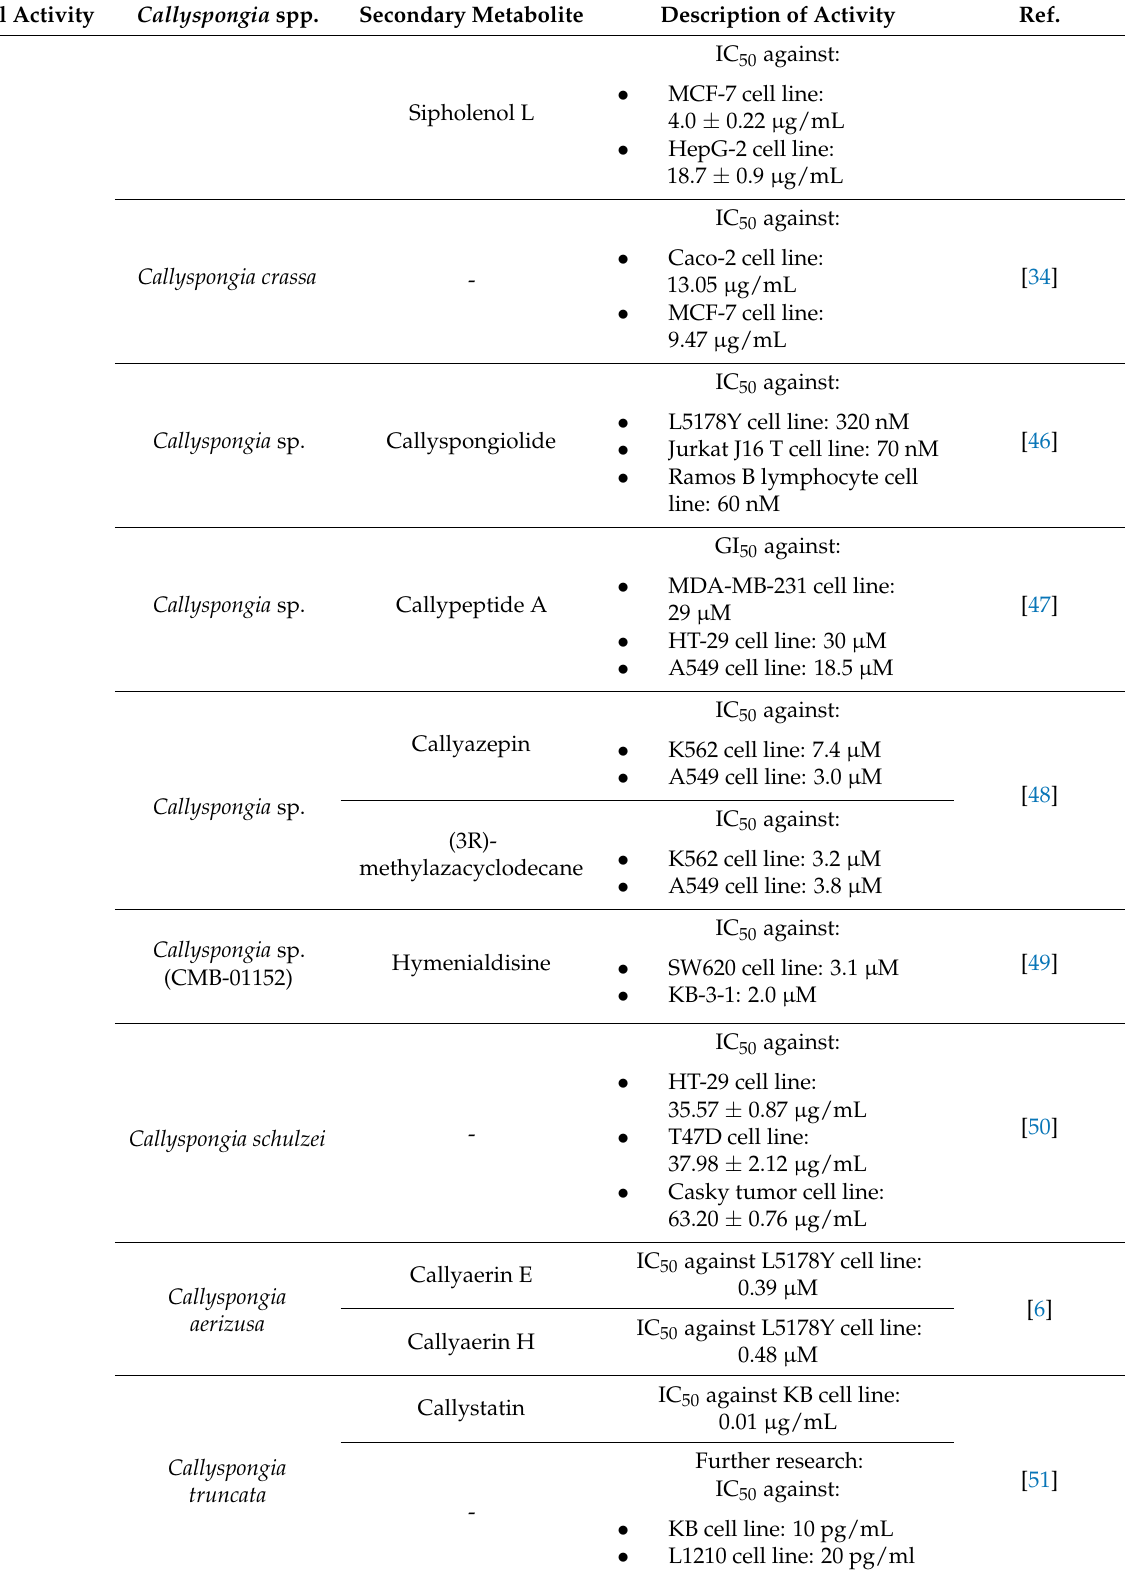
Pharmacological